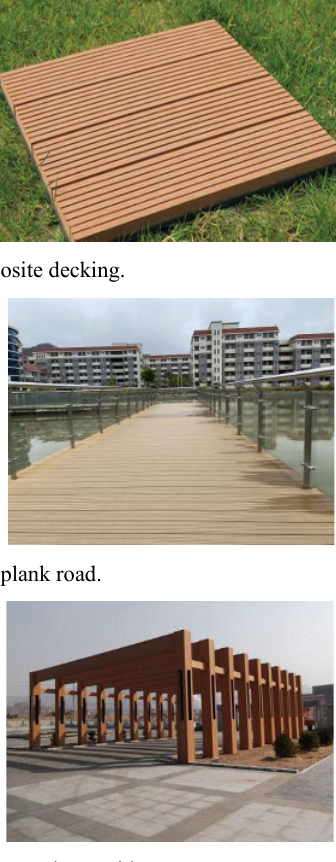
Fig. 5. Effect of wood-plastic composite